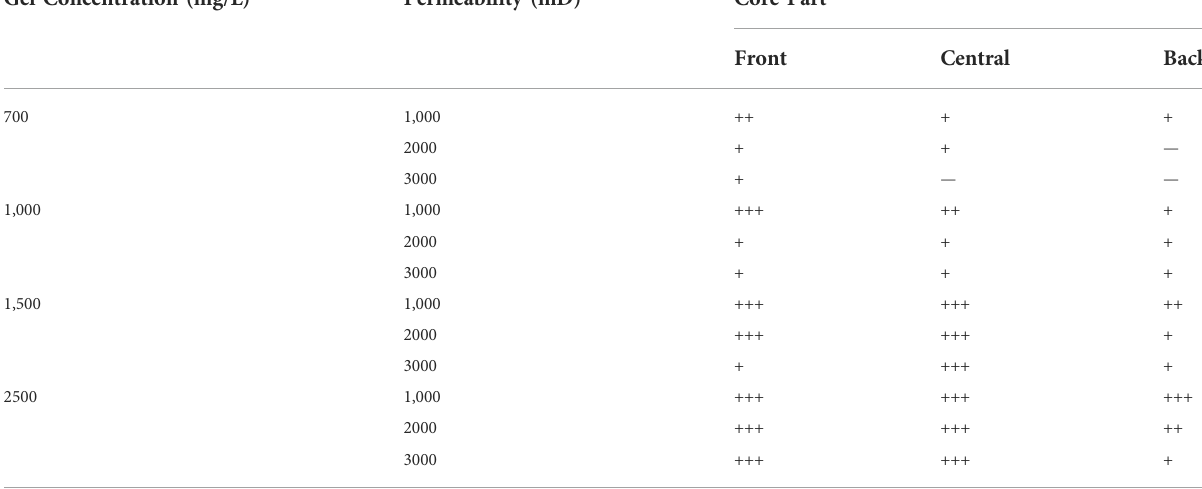
TABLE 5 Gel display of various parts of the core under electron microscope. Gel Concentration (mg/L)